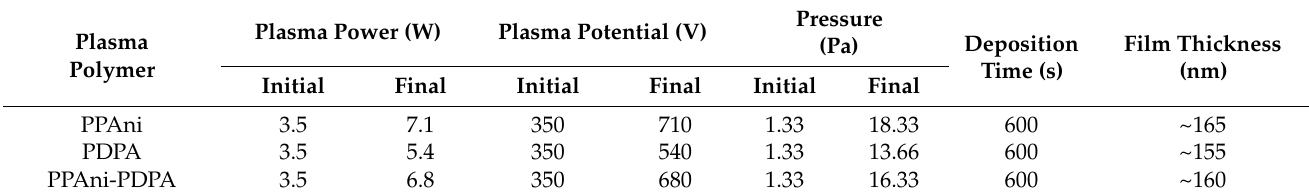
Table 1. Process parameters for PPAni, PDPA, and